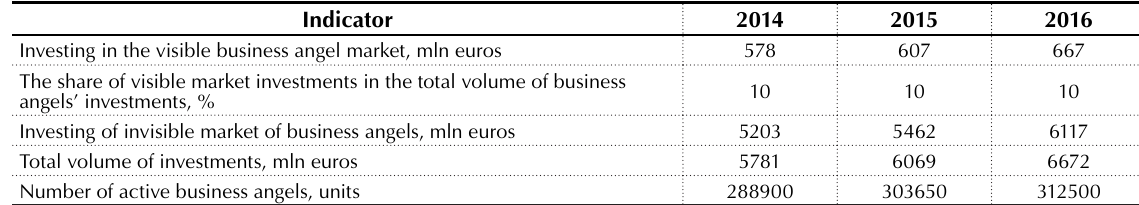
Table 2. Dynamics of investments of EU business angels in terms of their visible and invisible share in